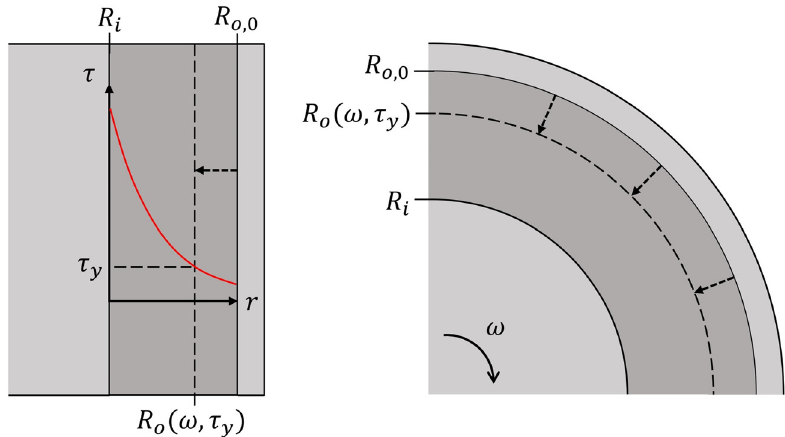
Figure 7: Schematic representation of the angular velocity and yield stress dependent gap reduction from R o,0 to R ω τ , y o ( ) in the presence of τ τ y o > from the sectional view with shear stress pro fi le ( left ) and the plan view ( right )